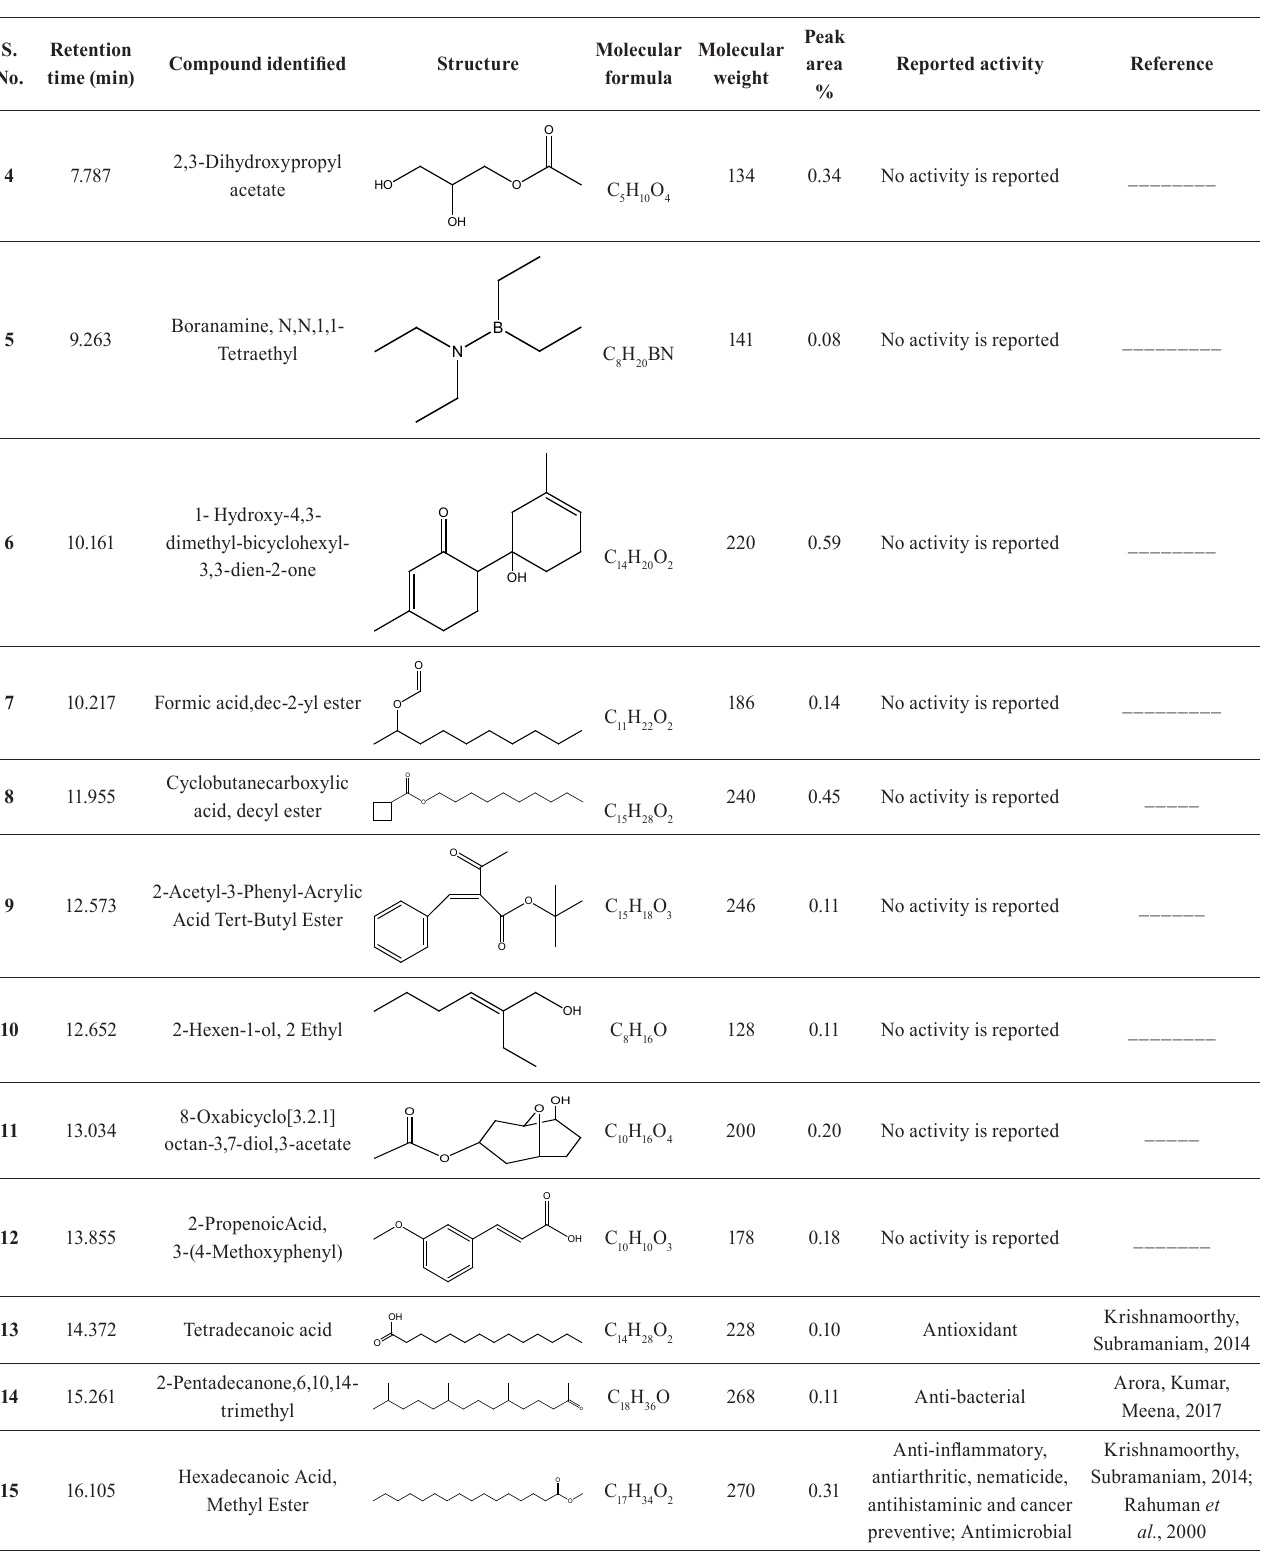
TABLE IV - List of phytocomponents identified by Gas Chromatography Mass Spectrometry (GC-MS) analysis of EAE of N. arbor- tristis L. seed and their bioactivity S. No.